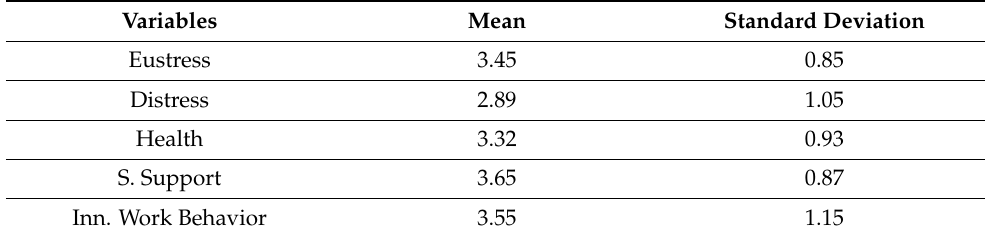
Table 2. Mean and standard deviations of the studied